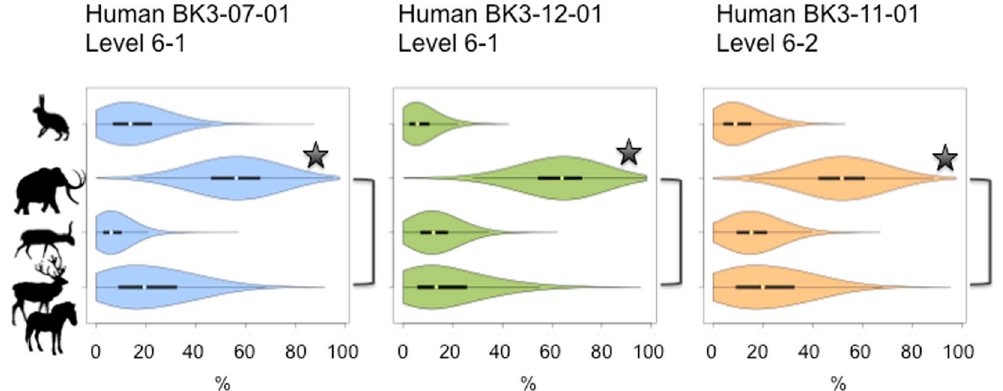
Figure 4. Proportional contribution of Deer&Horse (red deer and horse), Saiga (saiga antelope), Mammoth (woolly mammoth) and Hare (hare) (from bottom to top along the y axis) as estimated by SIAR using the considering both δ 13 C coll and δ 15 N coll values for human remains from Buran-Kaya III layers 6-2 and 6-1. Black boxes and whiskers show the median with 1 st and 3 rd quartiles and ranges with 1.5 times length of the interquartile range above the 3 rd quartile or below the 1 st quartile, respectively. The shaded area indicates the Kernel density plot of the probability density of prey proportions. The brackets link the resources with a significant negative correlation in their posterior distribution. Stars are placed close to the food resource whose significant contribution is in accordance with the δ 15 N Phe values.